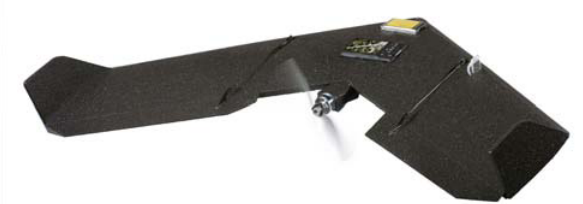
Figure 1: The Swinglet from Sensefly. The wingspan is only 80cm and the total weight including sensing device is